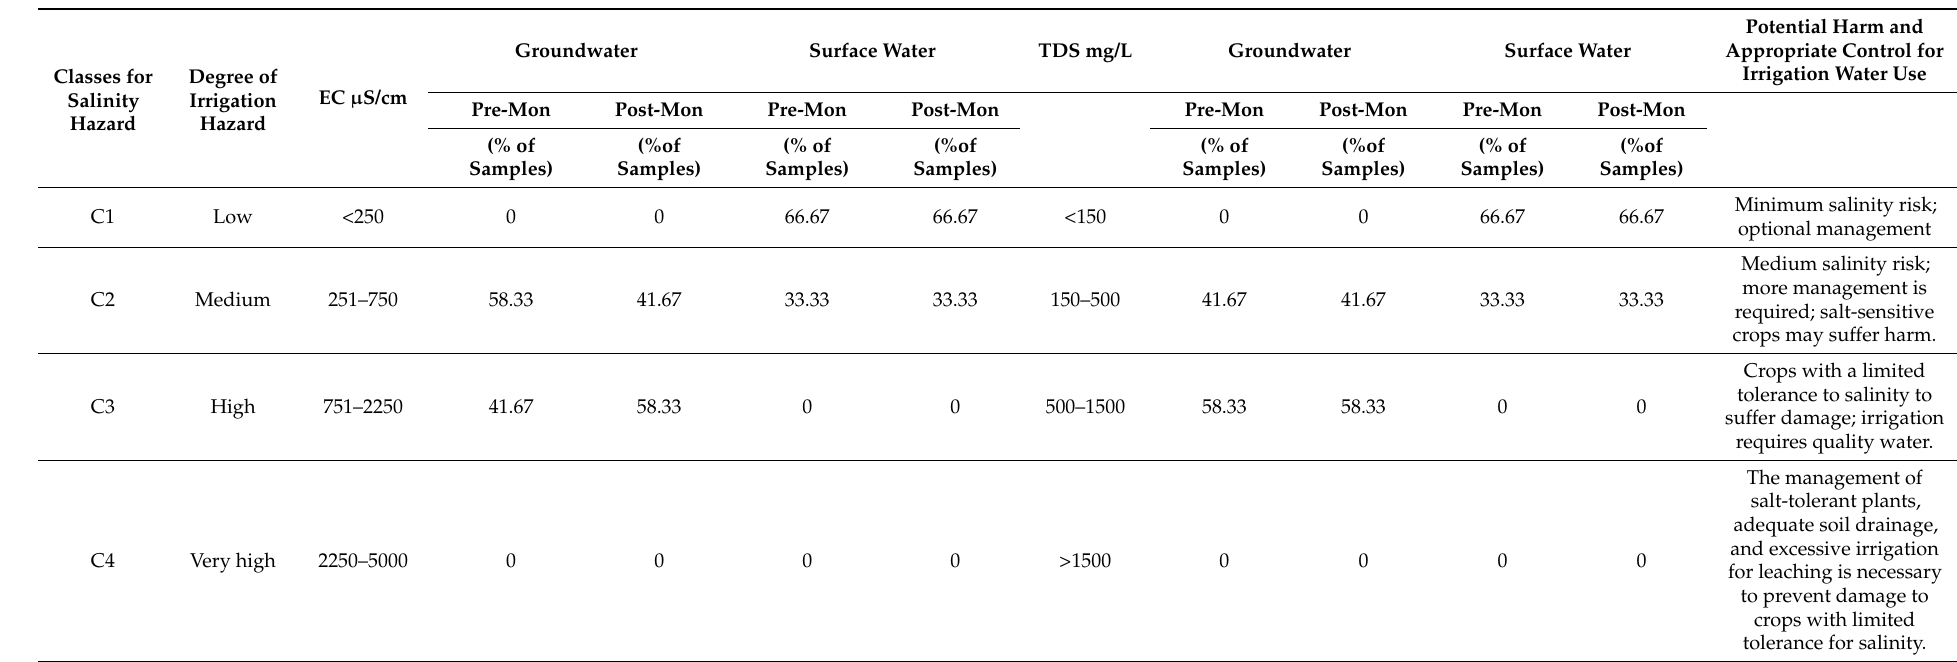
Table 6. Irrigation water quality classes for salinity hazard according to